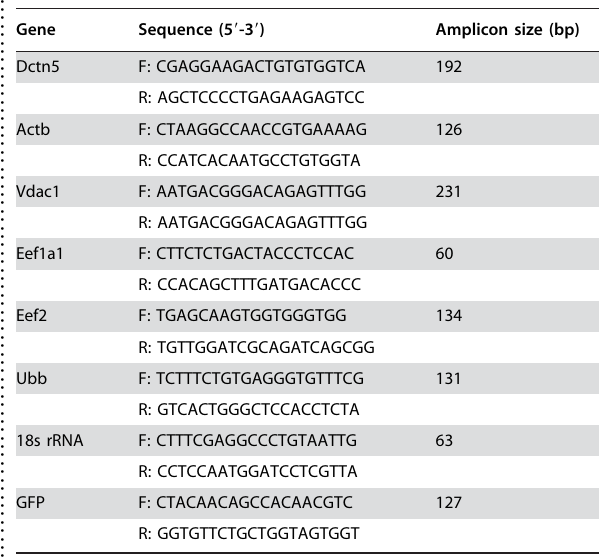
The table lists the sequences (5 9 to 3 9 ) of the forward and reverse primers used in real time PCR reaction to amplify various gene transcripts. The size of the amplicon is given as base pairs (bp). The designation ‘‘F’’ indicates forward and ‘‘R’’ indicates